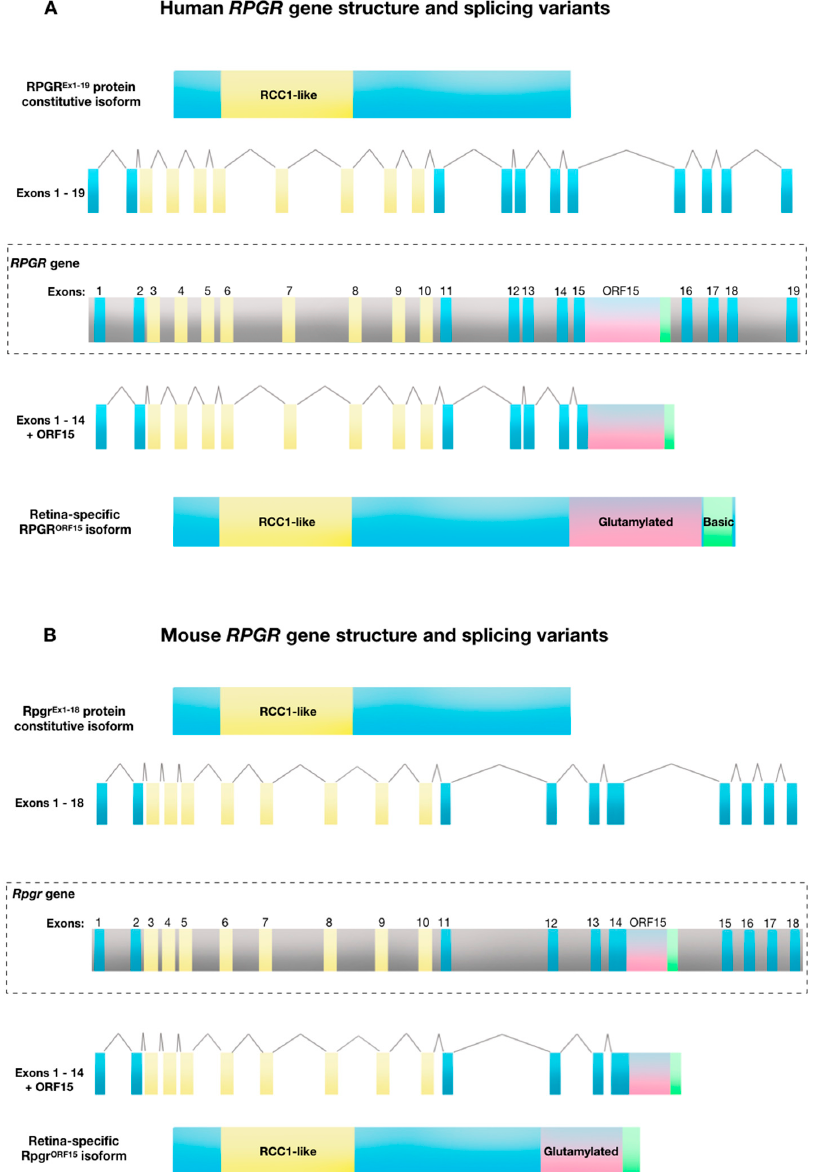
Figure 1. Retinitis Pigmentosa GTPase Regulator (RPGR) gene structure and splicing variants. ( A ) Human RPGR gene exon-intron structure showing the combination of exons 1 to 19 to create the constitutive protein isoform, and alternative splicing of exon 15 / intron 15 that creates the RPGR ORF15 variant. ( B ) Mouse RPGR gene exon-intron structure showing the combination of exons 1 to 18 to create the constitutive protein isoform and alternative splicing of intron 14 creates the RPGR OFR15 variant. The retina-specific ORF15 domain is also highly evolutionarily conserved across varied